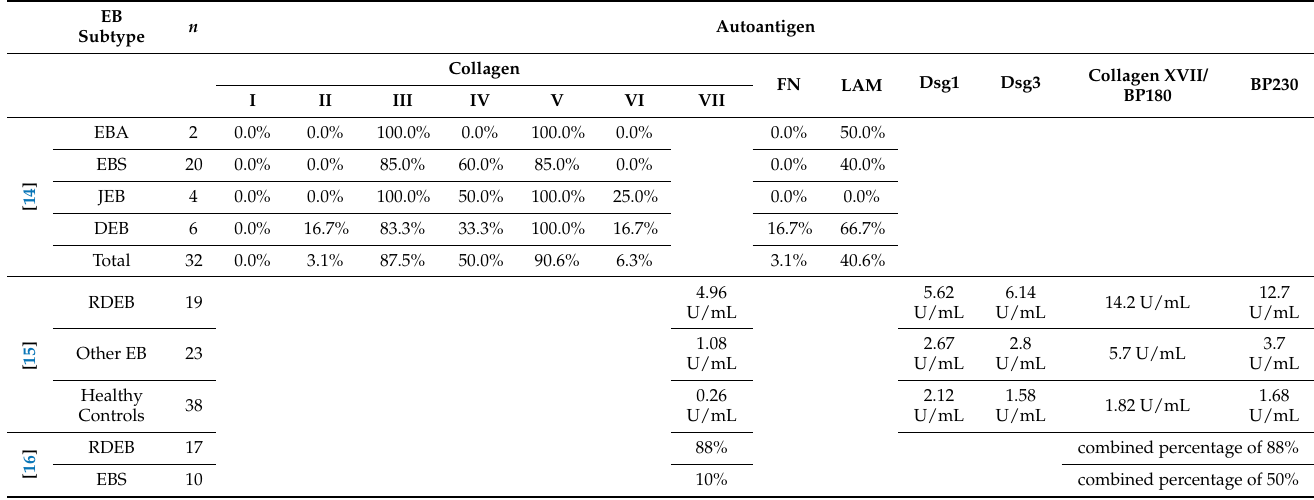
Table 2. Presence of autoantibodies in patients with